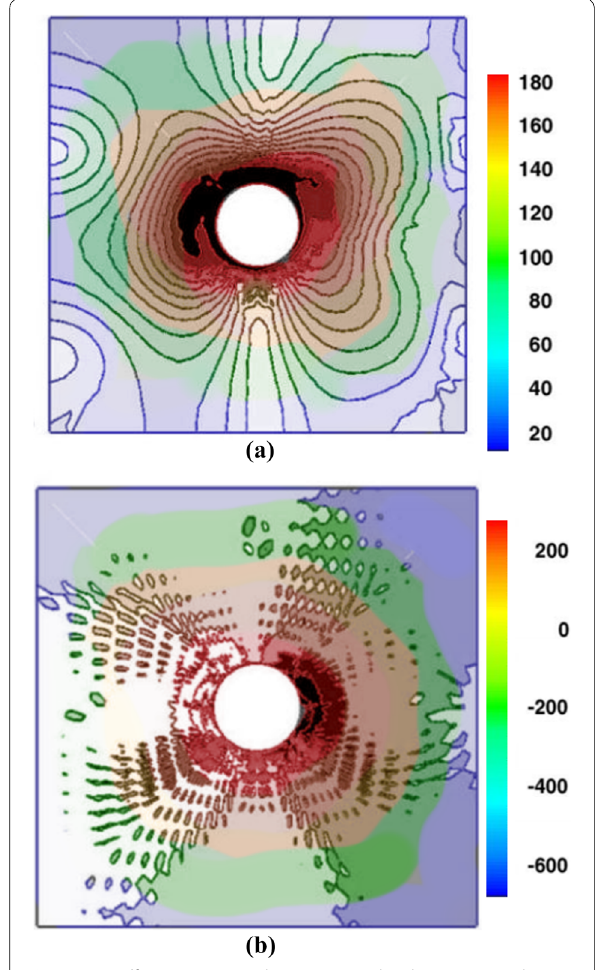
Figure 54 Effective stress and mean stress distributions over the Eulerian domain: ( a ) effective stress, and ( b ) mean stress